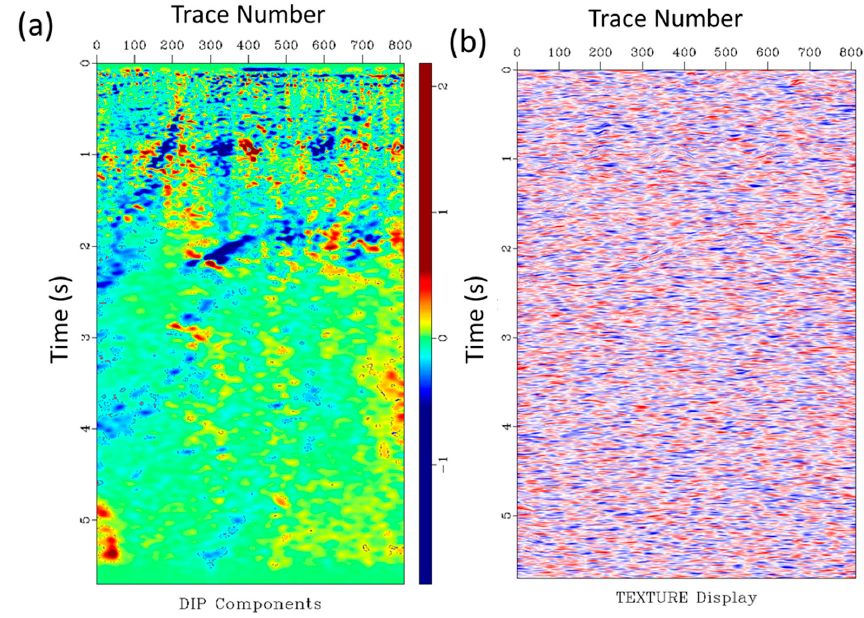
Figure 13. ( a ) Estimated dip field of data, and ( b ) texture computed by convolving field numbers with Figure 13: (a) Estimated dip field of data, and (b) texture computed by convolving field numbers with the inverse of the plane-wave destruction filters. the inverse of the plane-wave destruction filters. Geosciences 2018 , 8 , 74